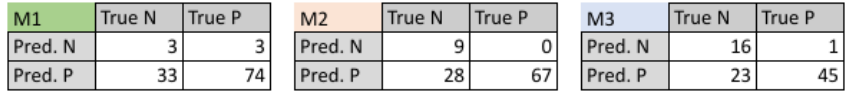
Figure 3. Performance of the F1 metric of each algorithm at each point in time M1, M2, M3.